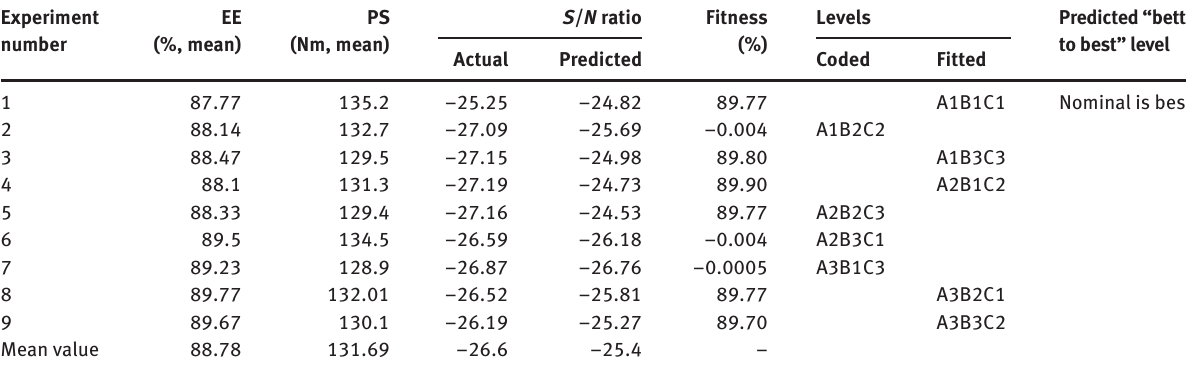
Table 3: The responses of various factors and output levels of observed vs. predicted levels on nine formulations. Experiment